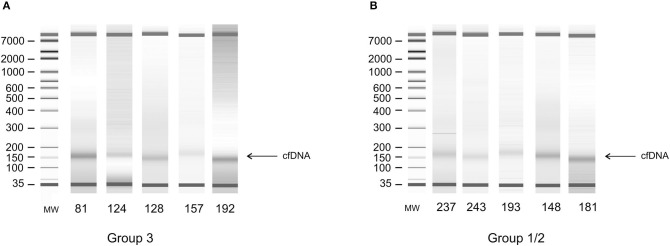
Electrophoretic runs of DNA extracted from plasma. (A) Random selected samples from alteration-negative (group 3) cfDNA. (B) Random selected samples from alteration-positive (group 1 or 2) cfDNA.